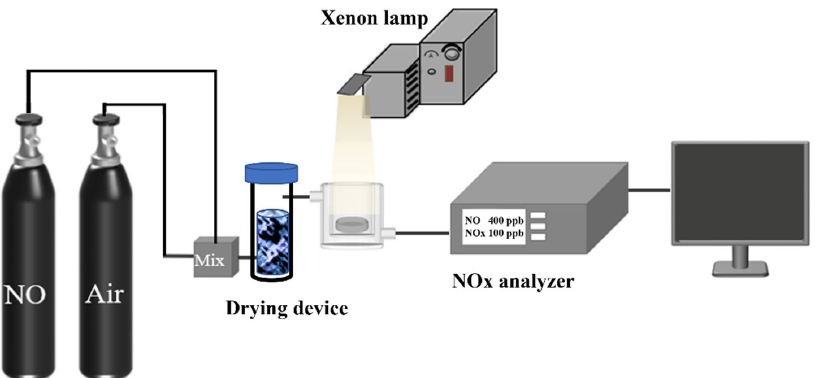
Figure 2. Experimental setup for the real ‐ time monitoring and testing of photocatalytic NO re ‐